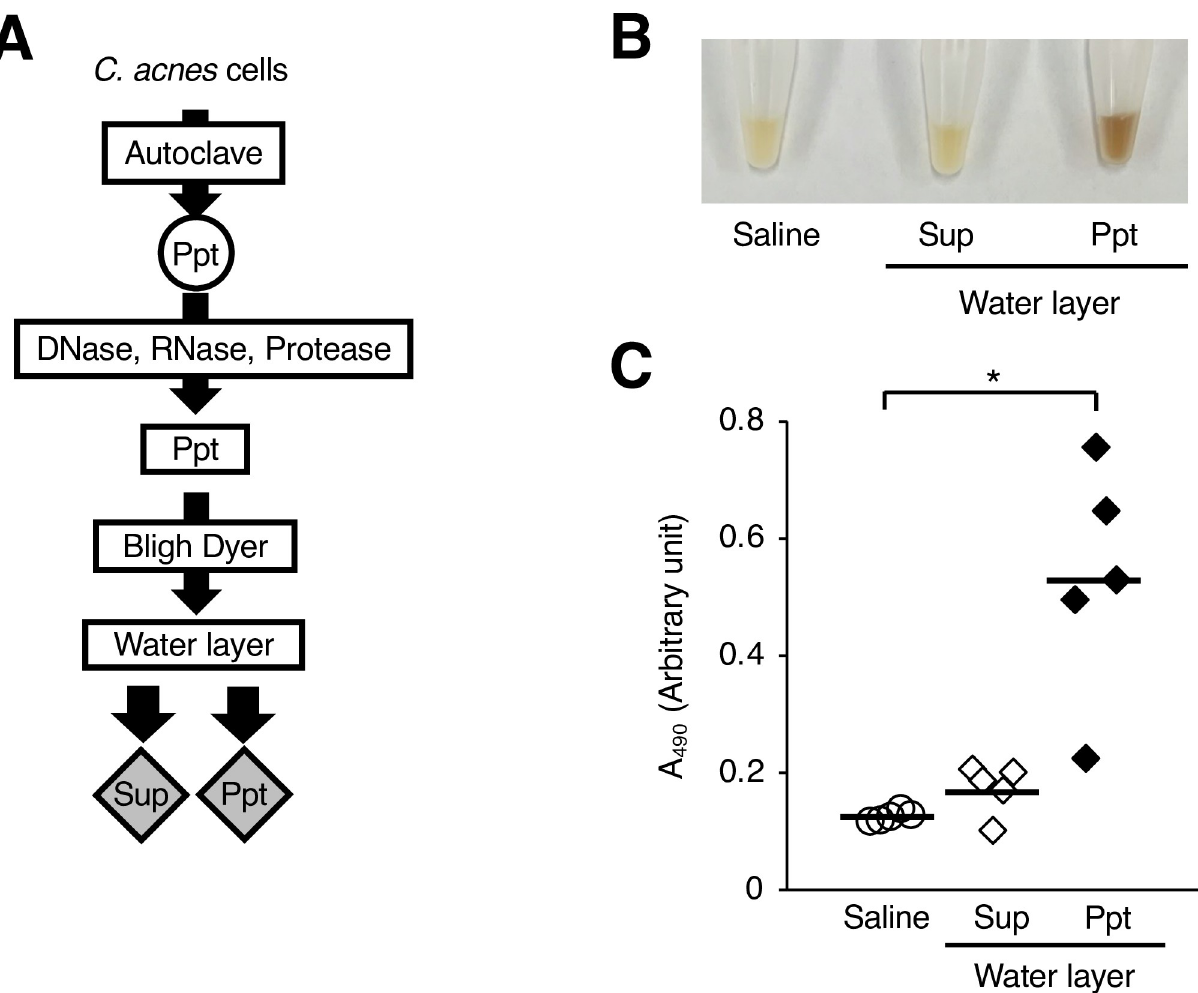
Fig 5. Induction of silkworm hemolymph melanization by injection of the water–insoluble C . acnes fraction obtained following the Bligh–Dyer procedure. ( A ) Preparation of the aqueous fraction and the chloroform–methanol fraction by the Bligh–Dyer method from the enzyme–treated C . acnes (AC) fraction ( C . acnes [Ac–En]). The water–soluble (Sup) and water–insoluble (Ppt) fractions were obtained. ( B , C ) Silkworms were injected with 50 μ l of saline (Saline), the water–soluble fraction (Sup), or the water–insoluble fraction (Ppt). After incubation for 3 h at 37˚C, the silkworm hemolymph was collected. Photographs of the silkworm hemolymph were taken ( B ) and absorbance at 490 nm (A490) ( C ) was measured. The arbitrary unit was defined as the absorbance at 490 nm of a sample of silkworm hemolymph (50 μ l) mixed with saline (50 μ l). n = 5/group. Statistically significant differences between groups were evaluated using the Tukey test. � P <